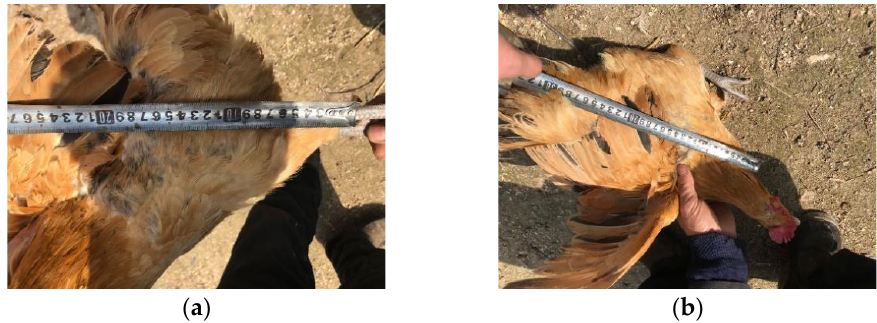
Table 1. Frequency modulation scheme of Fan A and Fan B.